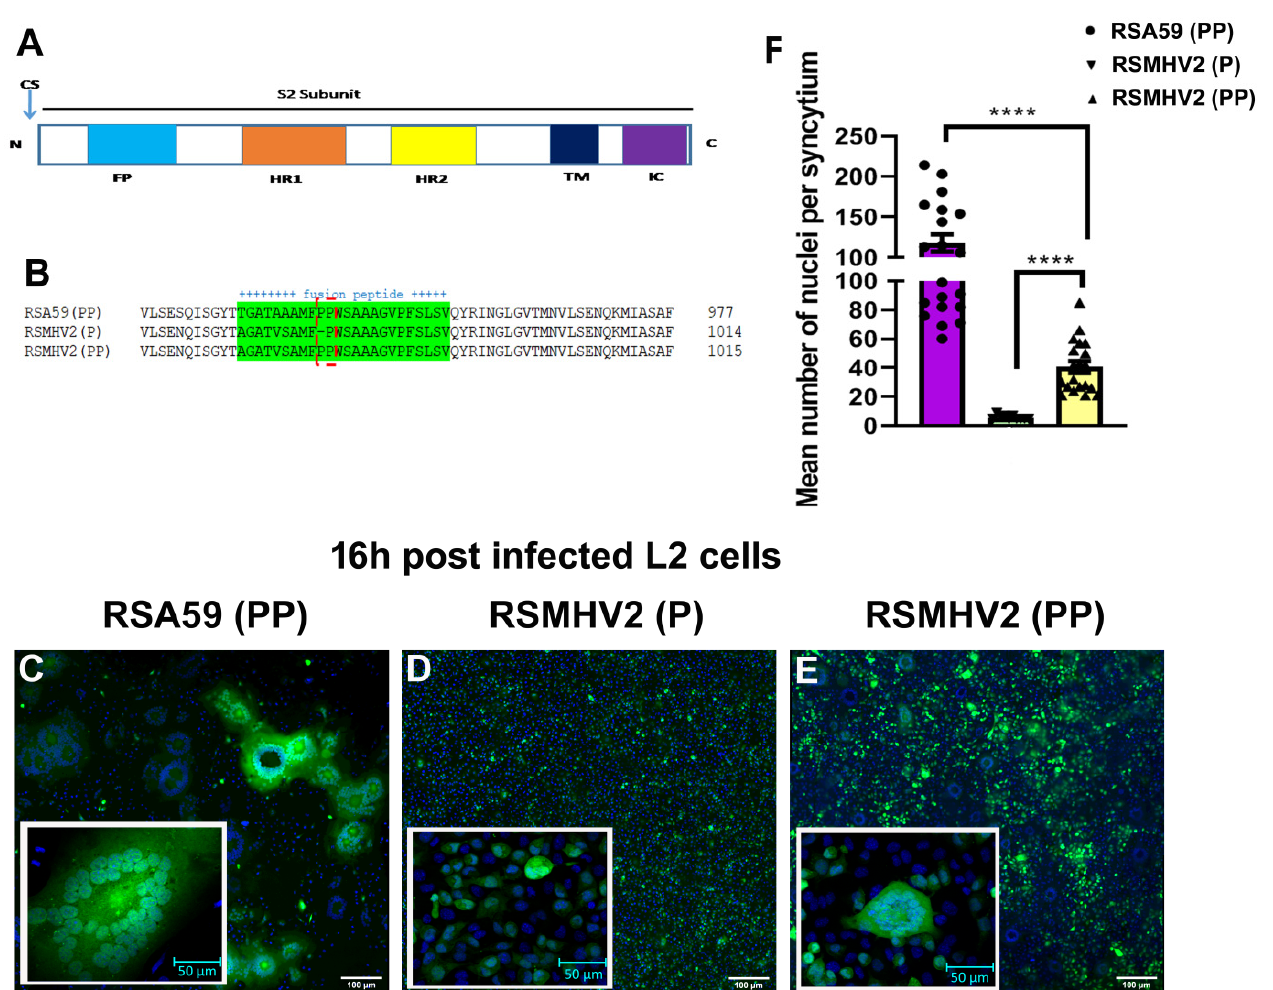
Figure 1. Sequence comparison of fusion peptide and fusogenic properties of RSA59 (PP), RSMHV2 (P), and RSMHV2 (PP) in L2 cells . Schematic of the S2 subunit of coronavirus Spike gene, showing cleavage site (CS), FP, heptad repeat 1 (HR1), heptad repeat 2 (HR2), transmembrane domain (TM), and intracellular tail (IC) ( A ). FP region of RSA59 (PP), RSMHV2 (P), and RSMHV2 (PP) sequences are aligned using ClustalW tool, dashed lines show central double proline (PP) or single proline (P) in RSA59 (PP), RSMHV2 (PP), and RSMHV2 (P), respectively ( B ). A monolayer of L2 cells was infected with RSA59 (PP), RSMHV2 (P), and RSMHV2 (PP) at MOI 0.5. The cells were incubated for 16 h at 37 °C with 5% CO 2 , fixed with 4% paraformaldehyde, and mounted in DAPI containing mounting media. Epifluorescence microscopy was performed, and images were acquired and further processed using Image J (Fiji) software. The green fluorescence is the intrinsic viral EGFP that is incorporated into the genome. Images of DAPI (blue) and EGFP (green) were merged to construct the images presented. RSA59 (PP) and RSMHV2 (PP) infection cause syncytia formation ( C , E ) but RSMHV2 (P) infection rarely formed syncytia ( D ). The mean nuclei per syncytium were quantified and scatter-bar plotted ( F ). Experiments were repeated five times. Significance level was taken at p < 0.05 following unpaired t -test analysis. **** p < 0.00001.